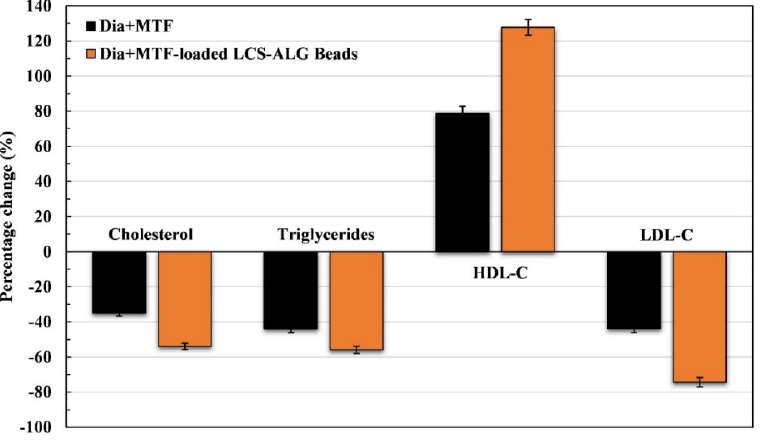
Figure 11. Percentage changes in lipid profile examined in Dia + MTF and MTF-loaded LCS-ALG bead groups relative to the Dia group at the end of the treatment period (29 days).